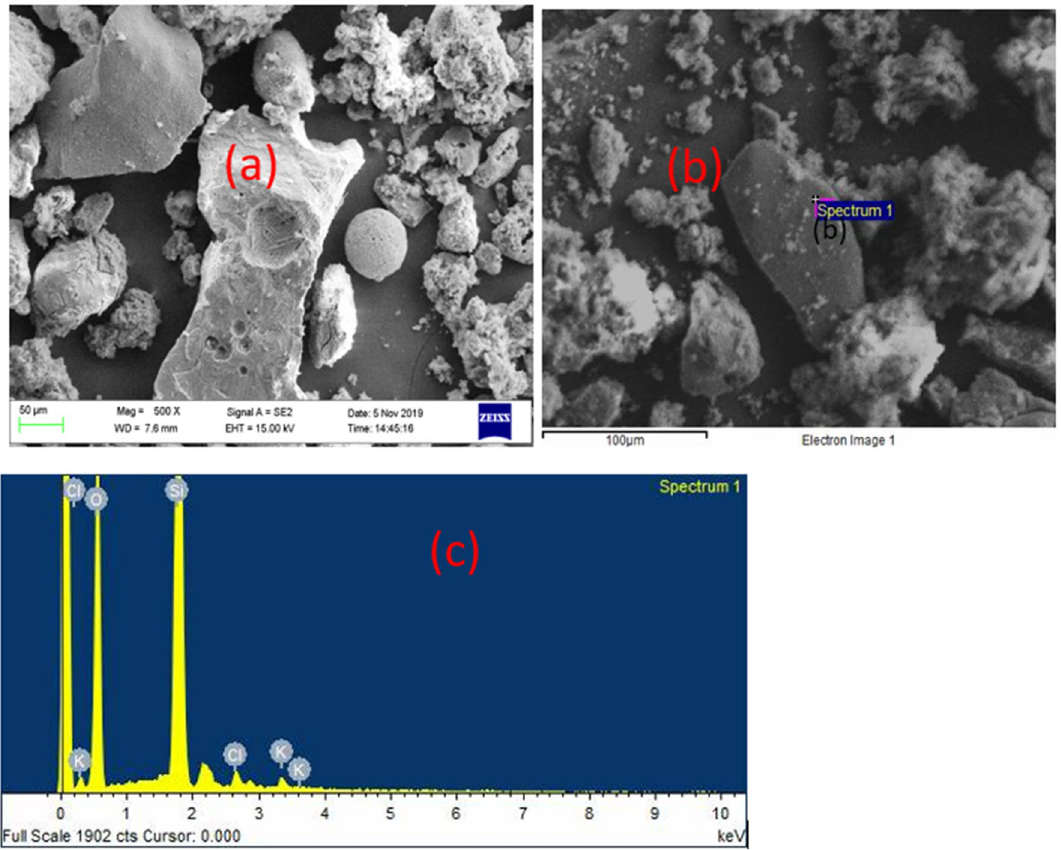
Figure 6. SEM microscopic analysis of SBAC SC-3-600, ( a ) multiple particle ( b ) focus on particle without cavity after activation and ( c ) qualitative analysis of the targeted